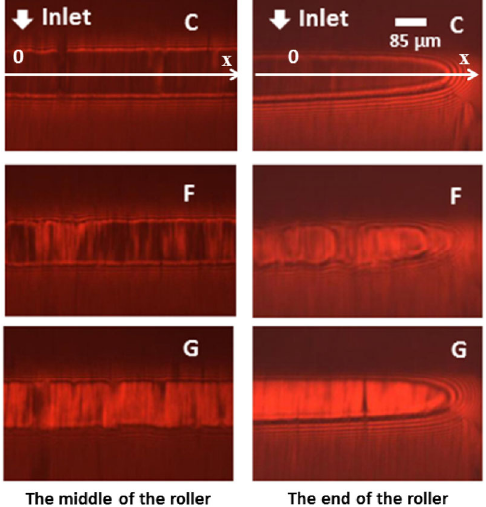
Fig. 4 Cylindrical roller profiles. Fig. 5 Interference images of three different types of grease ( u = 15 mm/s, p max =0.58 GPa, straight line